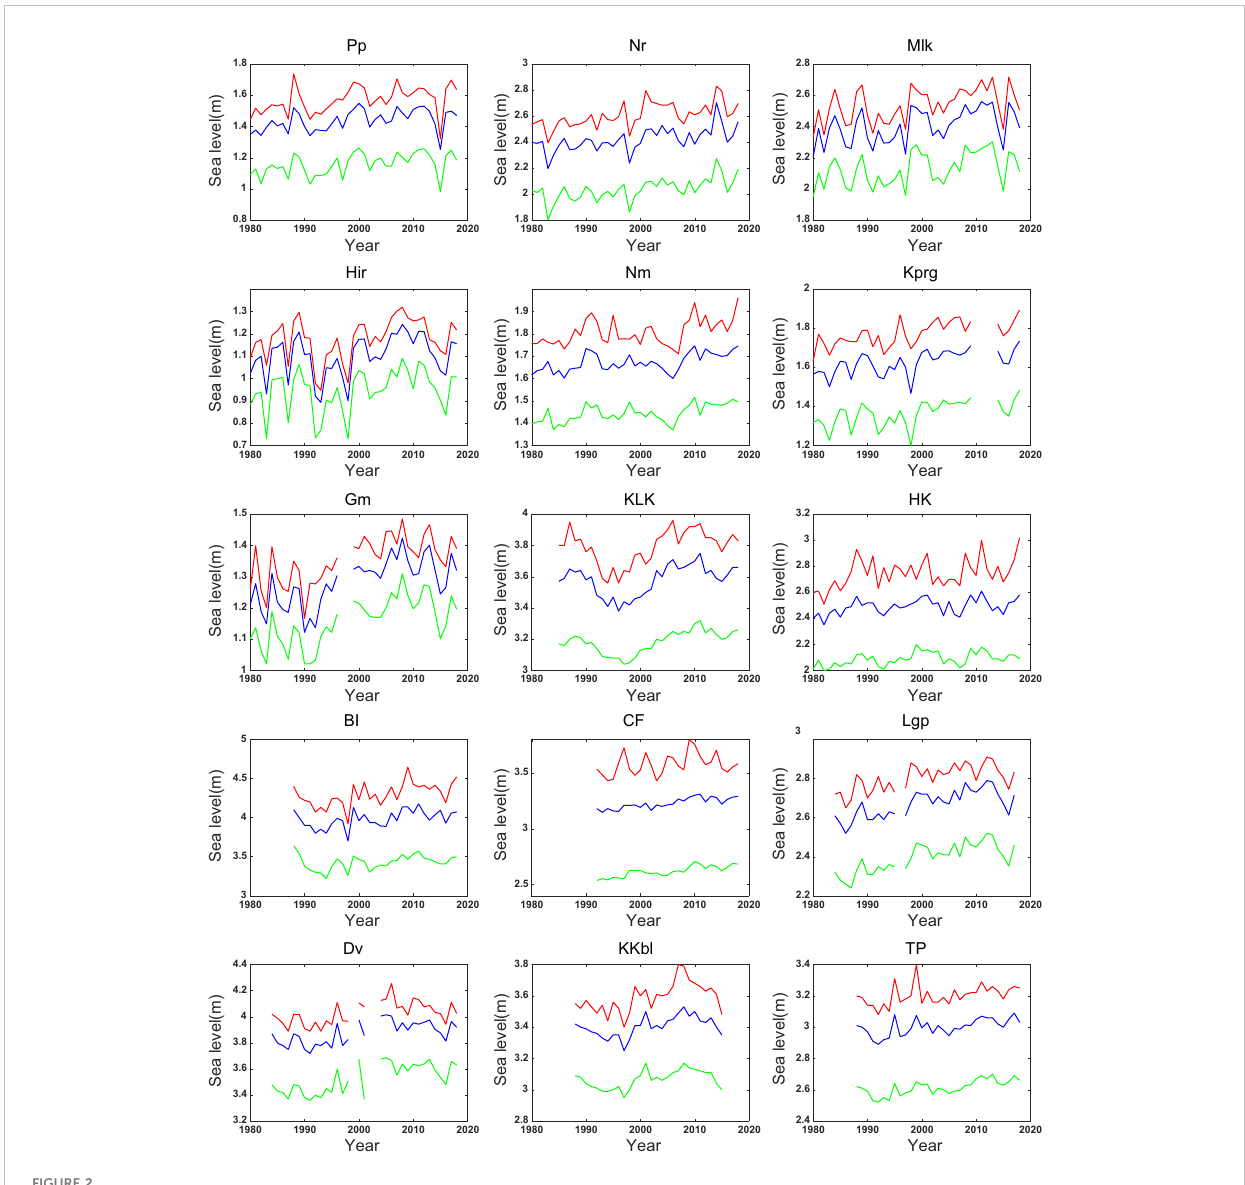
FIGURE 2 99.9% (red lines), 99% (blue lines), and 90% levels (green lines) of the observed sea levels at 15 tide